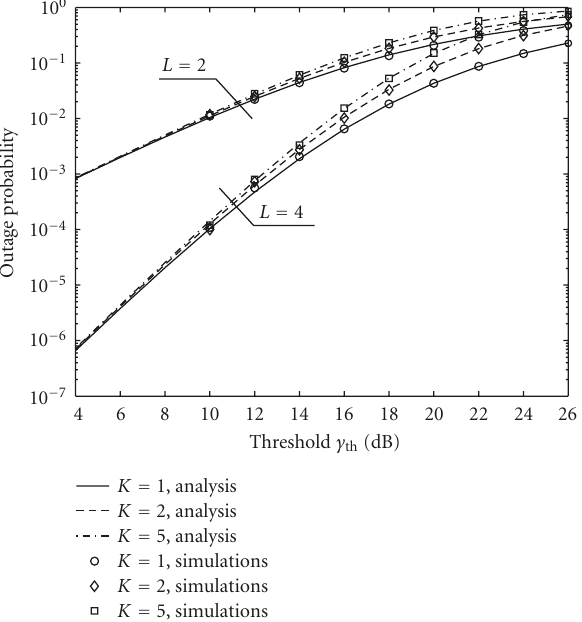
Figure 4: The e ff ect of changing the number of interferers on the performance of the SC receiver employing the maximum SIR crite- rion with m s = m I = 2, β = 1 and SIR av =